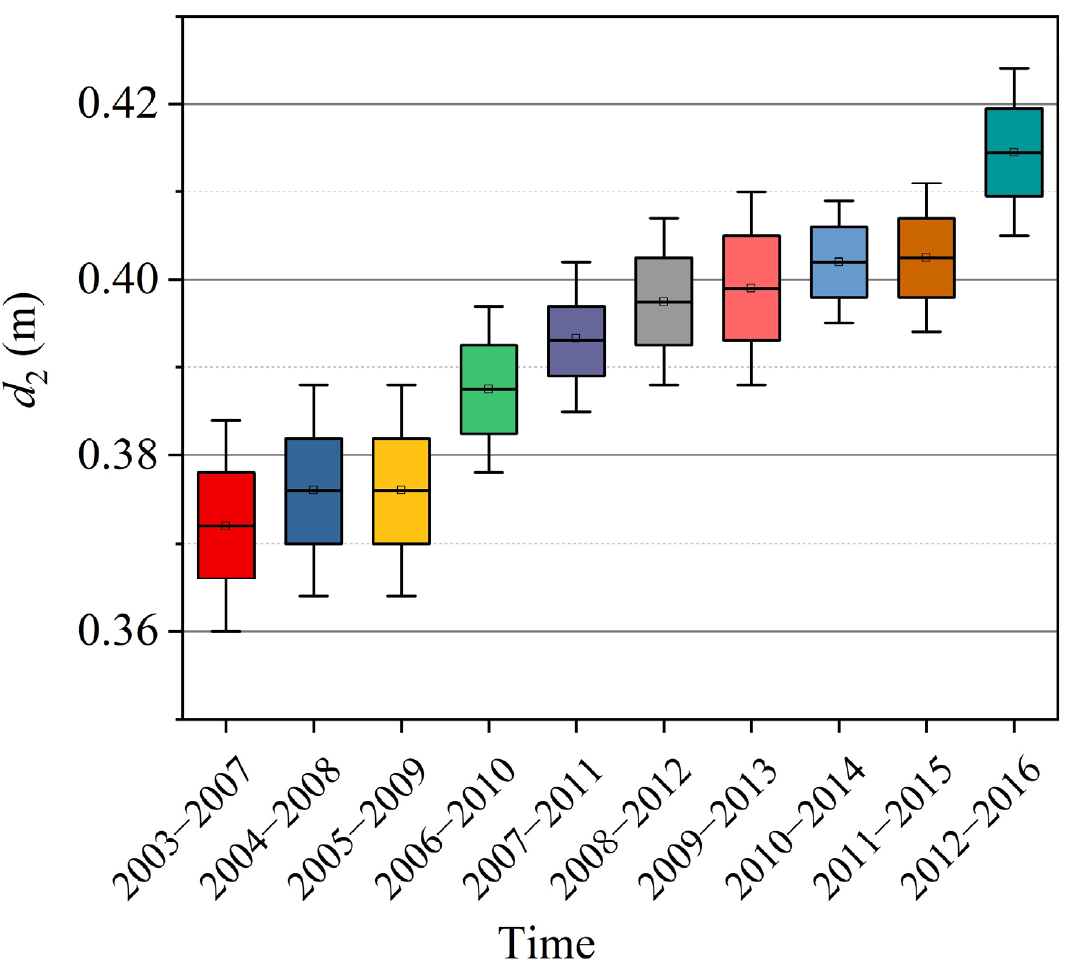
Figure 8. Distribution box diagrams of the VIC model parameter d 2 calibrated for different sliding window periods. (Note that only the optimal 25 d 2 parameters were chosen and plotted in the box diagram for each sliding period).